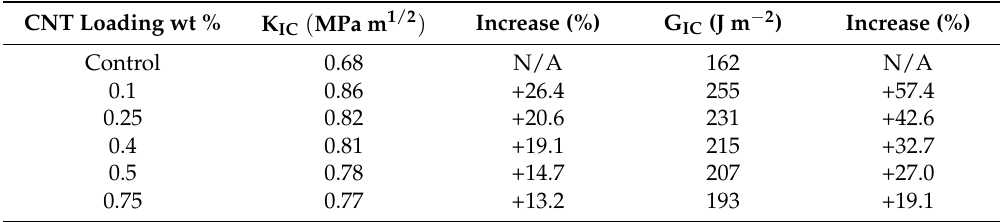
Figure 3. ( a ) Critical stress intensity factor, K IC , and ( b ) critical strain energy release rate, G IC , for f-MWCNT/Epoxy nanocomposites for different nanofiller loading. In all cases, error bars indicate standard deviation. Table 2. Variation of K IC and G IC for different f-MWCNT loading, along with percentage increase relative to the neat epoxy .